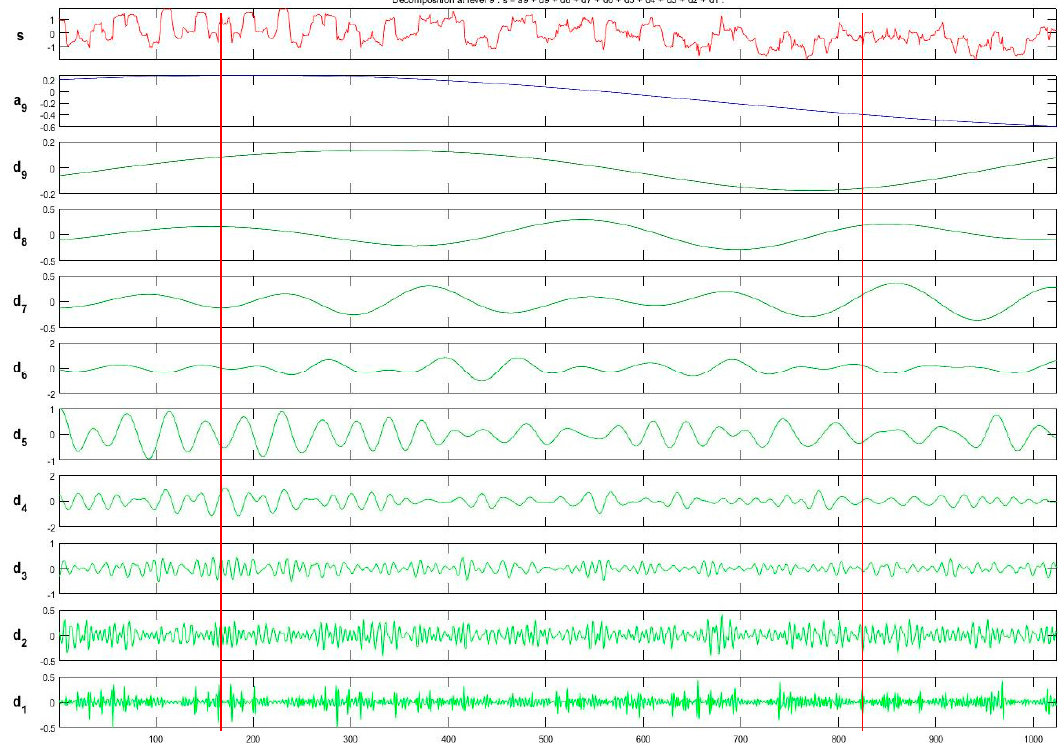
Figure 10. Wavelet decomposition of monthly SPEI12 values in the whole region.